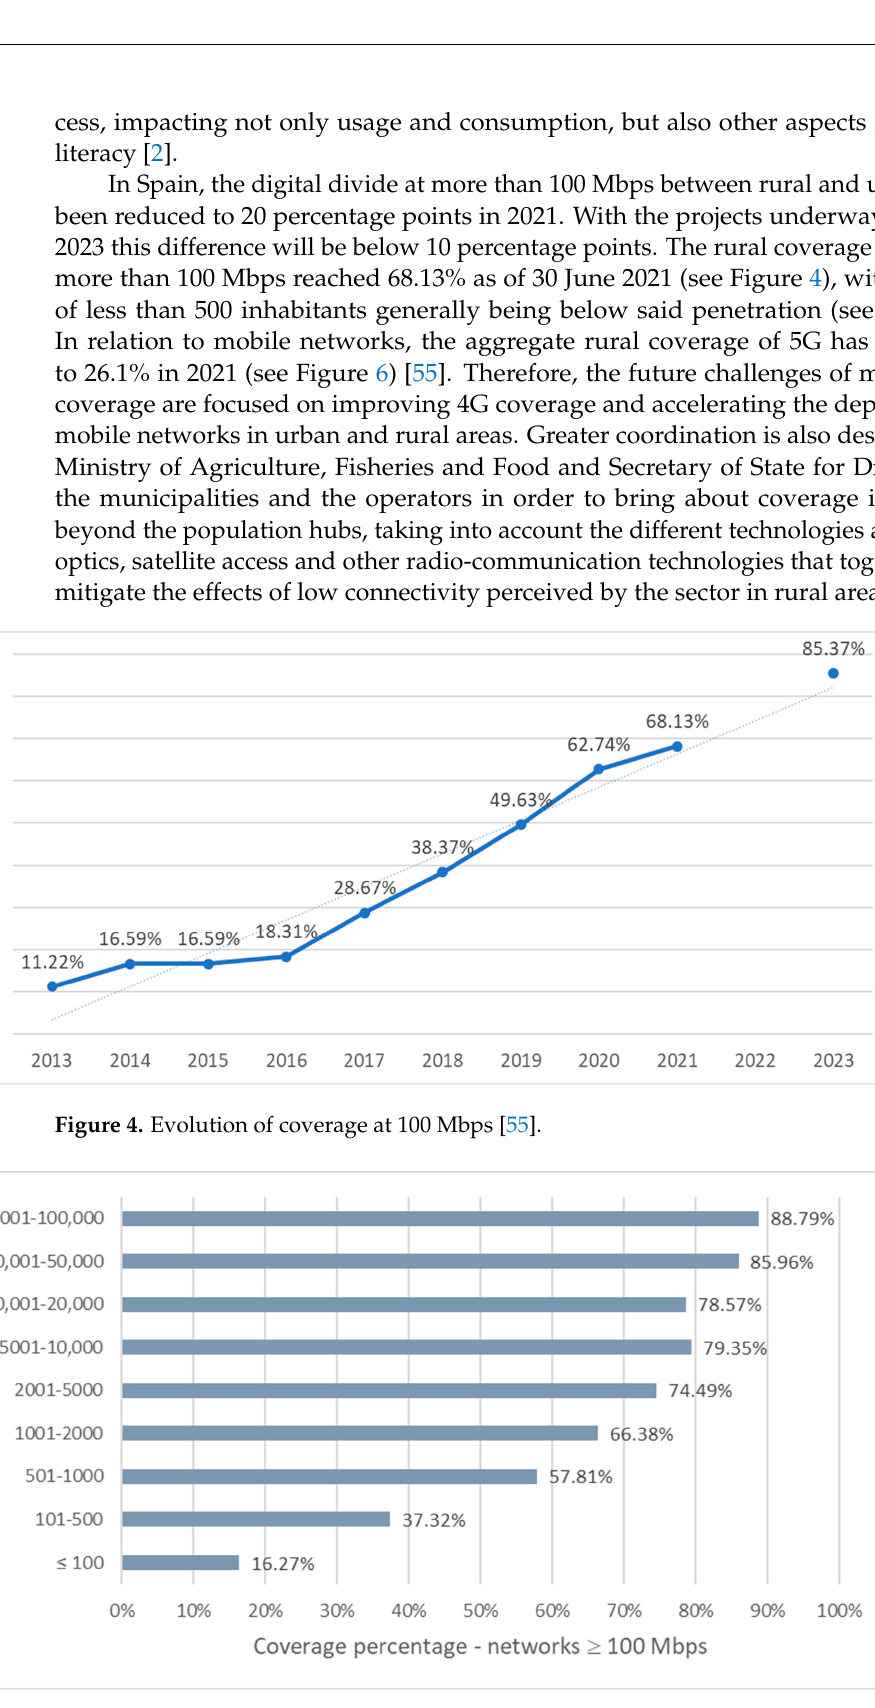
Figure 5. Coverage at speeds ≥ 100Mbps by population geotypes (30 June 2021) [55].